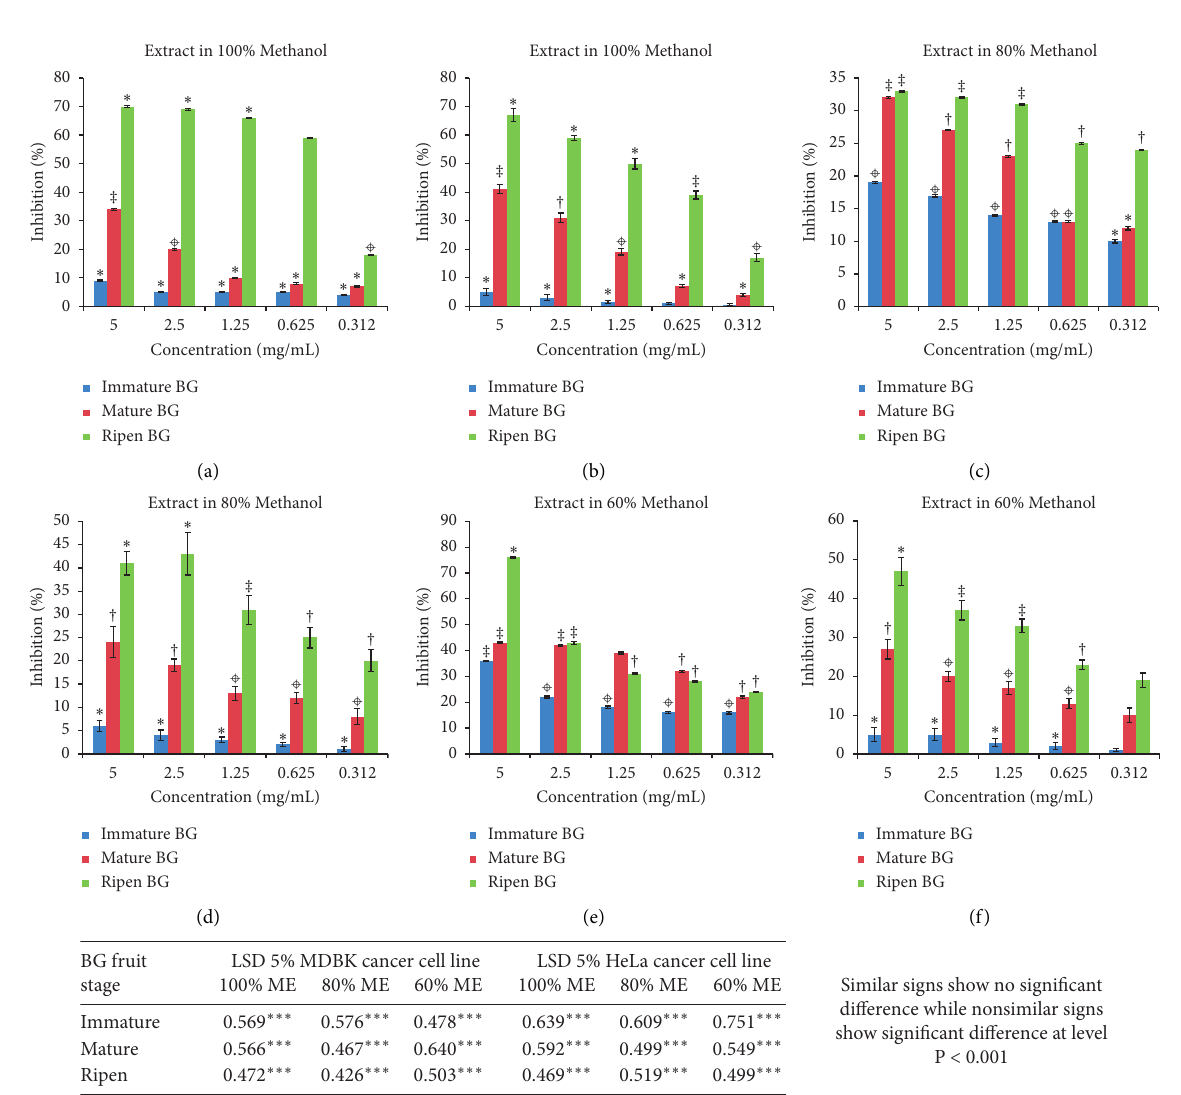
Figure 4: Anticancer activity of immature, mature, and ripen BG fruit extracts against MDBK and HeLa cancer cell line: (a) 100% methanol anticancer activity against MDBK cancer cell line; (b) 100% methanol extract anticancer activity against HeLa cancer cell line; (c) 80% methanol extract anticancer activity against MDBK cancer cell line; (d) 80% methanol extract anticancer activity against HeLa cancer cell line; (e) 60% methanol extract anticancer activity against MDBK cancer. cell line and (f) 60% methanol extract anticancer activity against HeLa cancer cell line. The LSD 5% values are represented in the table showing level of significant difference ( P < 0 .